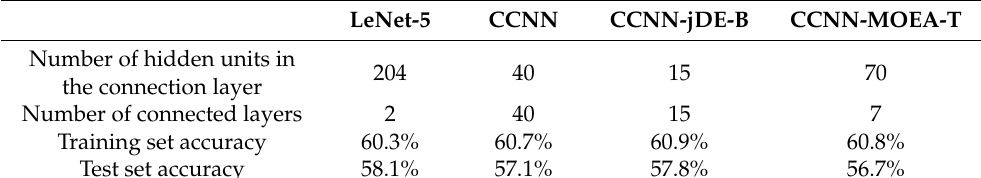
Table 6. The simulation results of the LeNet-5 pre-training and reconstruction on the CIFAR-10 classification.